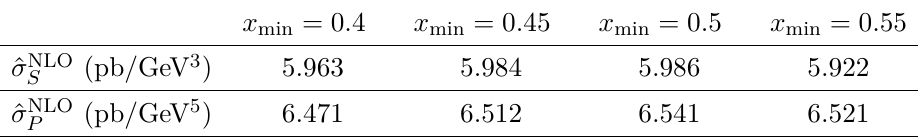
Table 2 . The coefficients of the integrated cross section in SGF with different x min